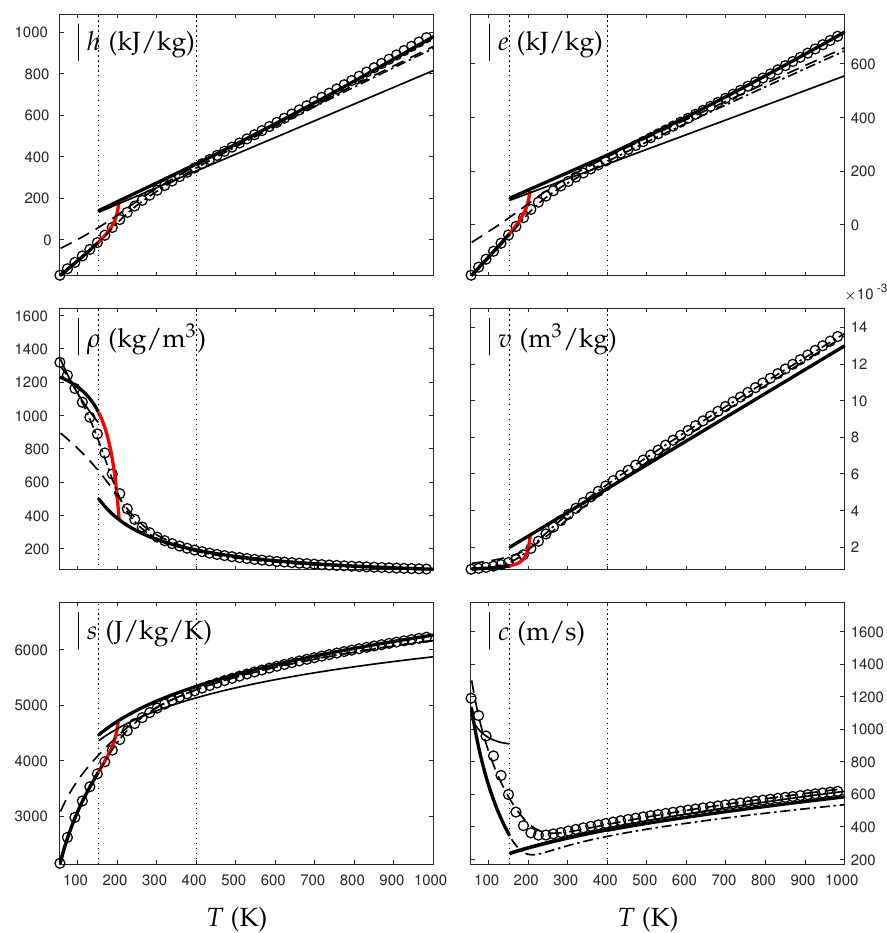
Figure 7. Comparison between experimental and theoretical isobar for oxygen. The symbols represent the experimental isobar p = 200 bars. Beyond the critical temperature T c = 154 K, the liquid transforms to supercritical state. The thick solid lines represent the Extended NASG (ENASG) EOS, reducing to the ideal gas description for the supercritical phase Equations (56), (57) and (60). The thin solid lines represent the original NASG EOS also reducing to the ideal gas formulation for the supercritical phase. The dashed lines represent the van der Waals (VdW) theoretical predictions and the dashed-dotted lines represent the Soave–Redlich–Kwong (SRK) ones. The critical temperature is indicated with the dotted lines. From this temperature, the liquid ENASG EOS is extended and joins the ideal gas EOS (except for the sound speed). The temperature T 0 = 400 K at which variable heat capacities are considered is indicated in dotted lines as well.